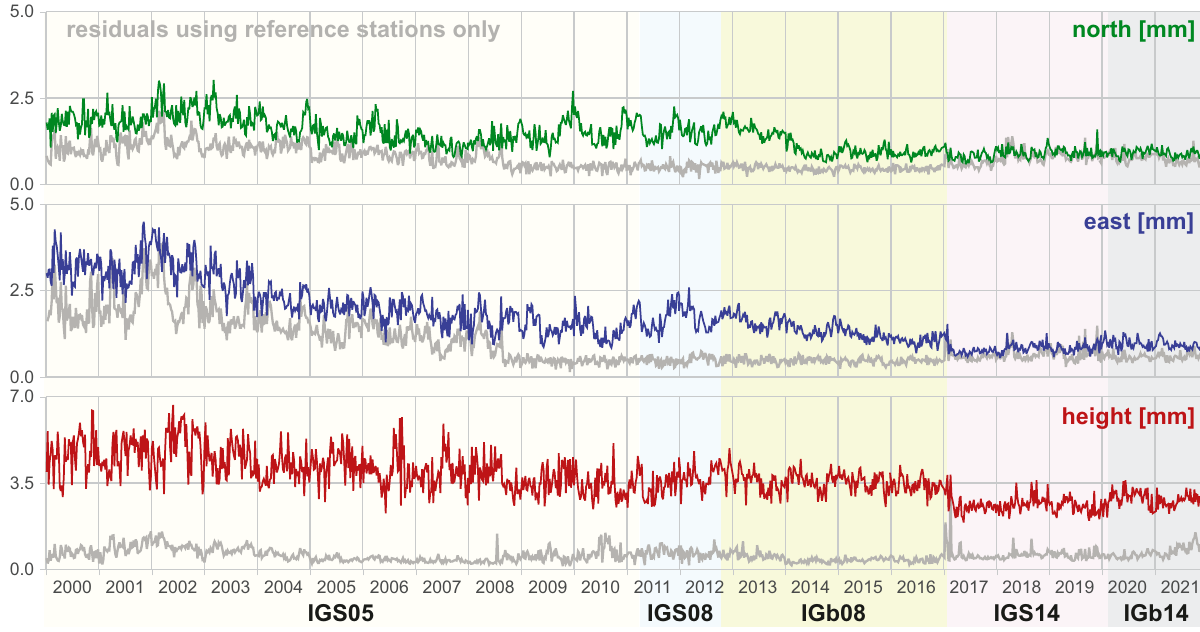
Figure 8: Mean RMS values of the station position residuals obtained after comparing the SIRGAS and IGS weekly position solutions. Grey lines represent the values obtained when comparing SIRGAS with the IGS fi ducial stations only; coloured lines represent the values obtained when comparing all SIRGAS/IGS common stations. Background colours indicate the IGS reference frame in use.